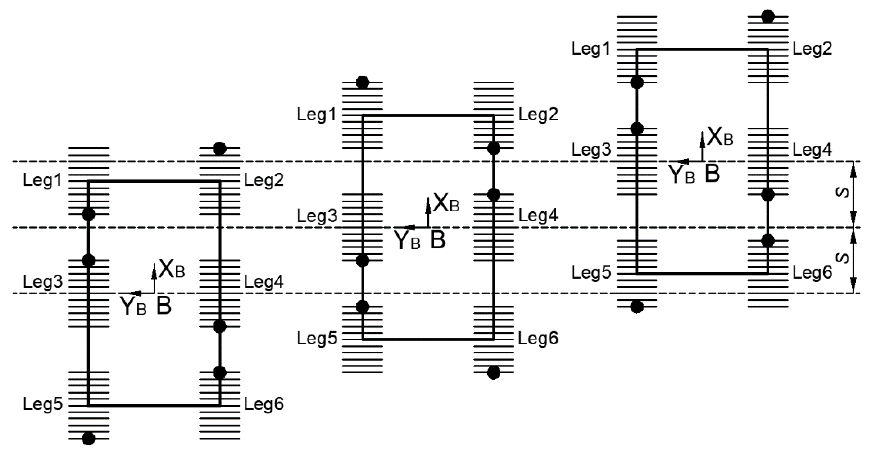
Figure 7. Walking forward using tripod gait.